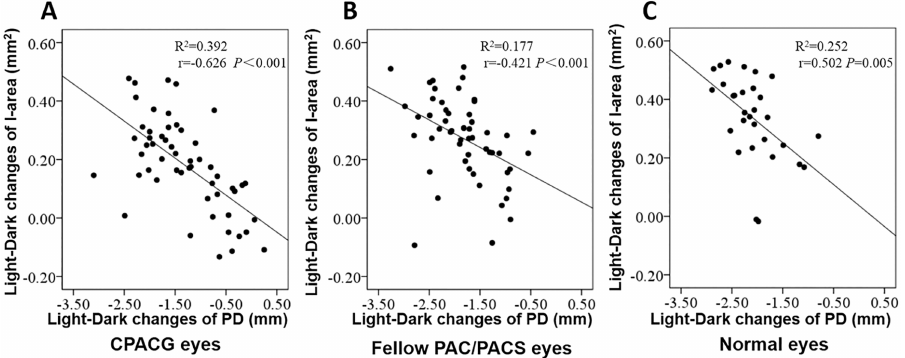
Fig 6. Relationship between mean PD change and I-area change after physiological mydriasis in CPACG eyes, fellow PAC/PACS eyes, and normal eyes. The I-area decreased with increasingpupil size in all three groups. A: For CPACG eyes, the linear regression equationof the scatter plot was y = 0.015–0.127x. B: For fellow PAC/PACS eyes, the linear regressionequation of the scatter plot was y = 0.101–0.094x. C: For normaleyes, the linear regression equationof the scatter plot was y = 0.037–0.144x. CPACG: chronic primary angle closureglaucoma;PAC: primary angle closure; PACS: primary angle closure suspect; PD: pupil diameter; I-area: iris